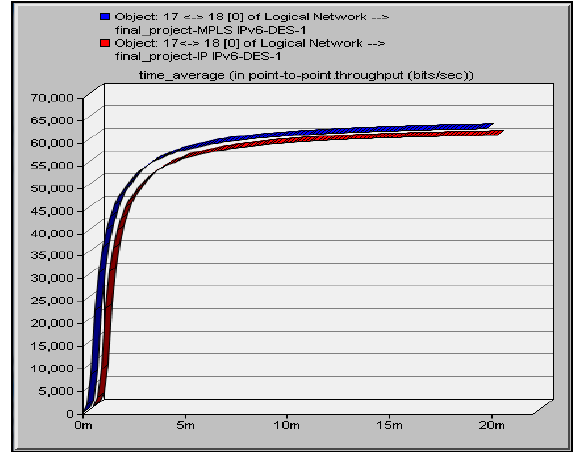
Figure 7 Average Throughput Comparison of IPv6 and MPLS IPv6 along 17 to 18 Link